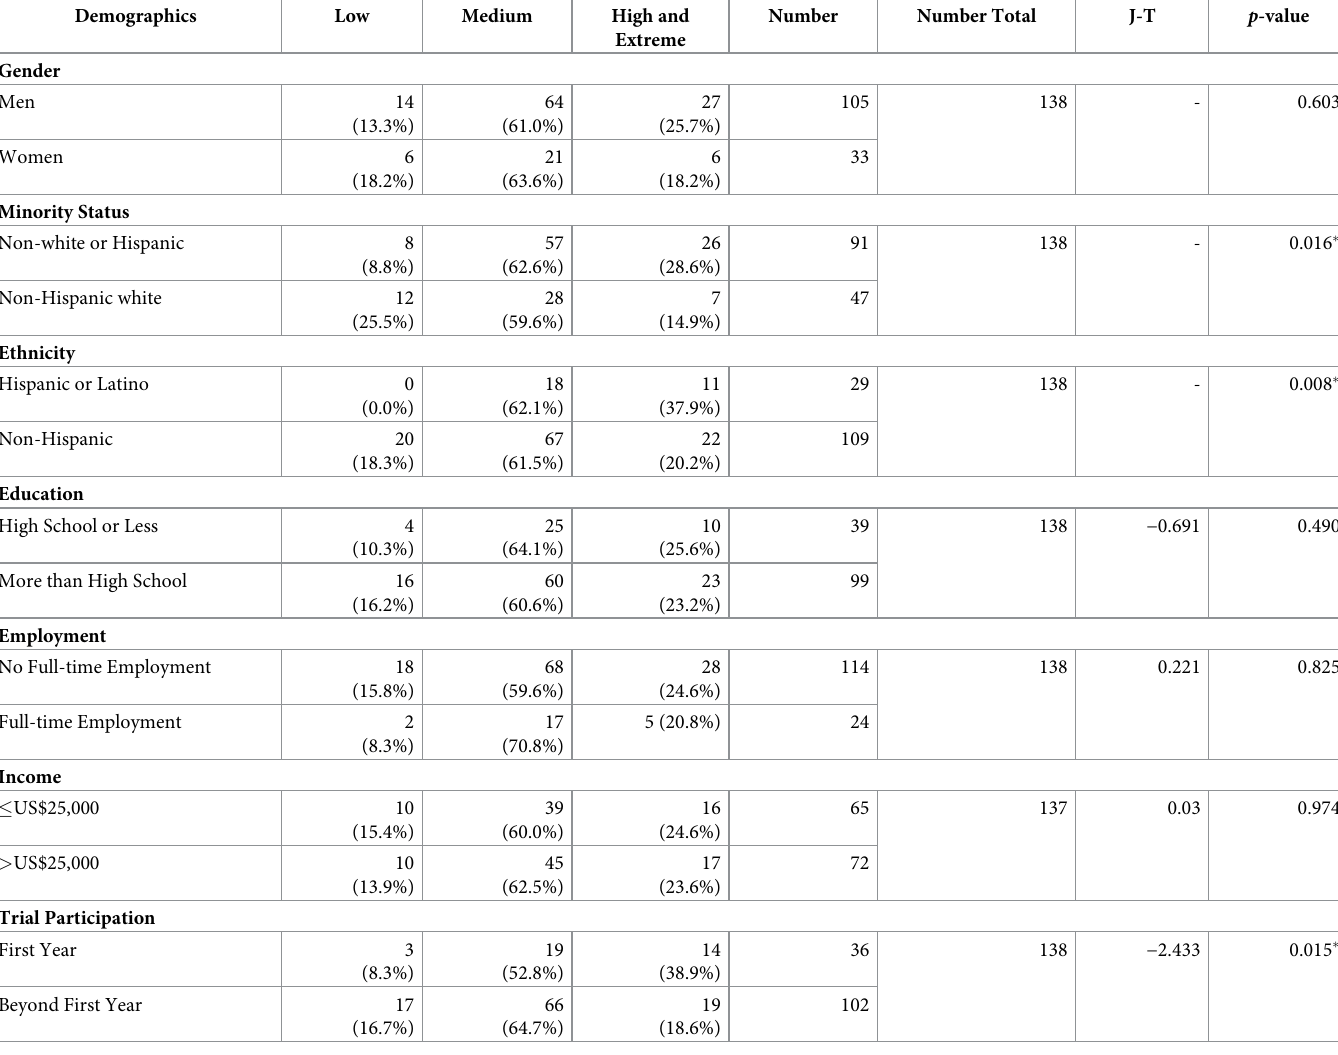
Table 3. Demographic differences in perceptions of overall